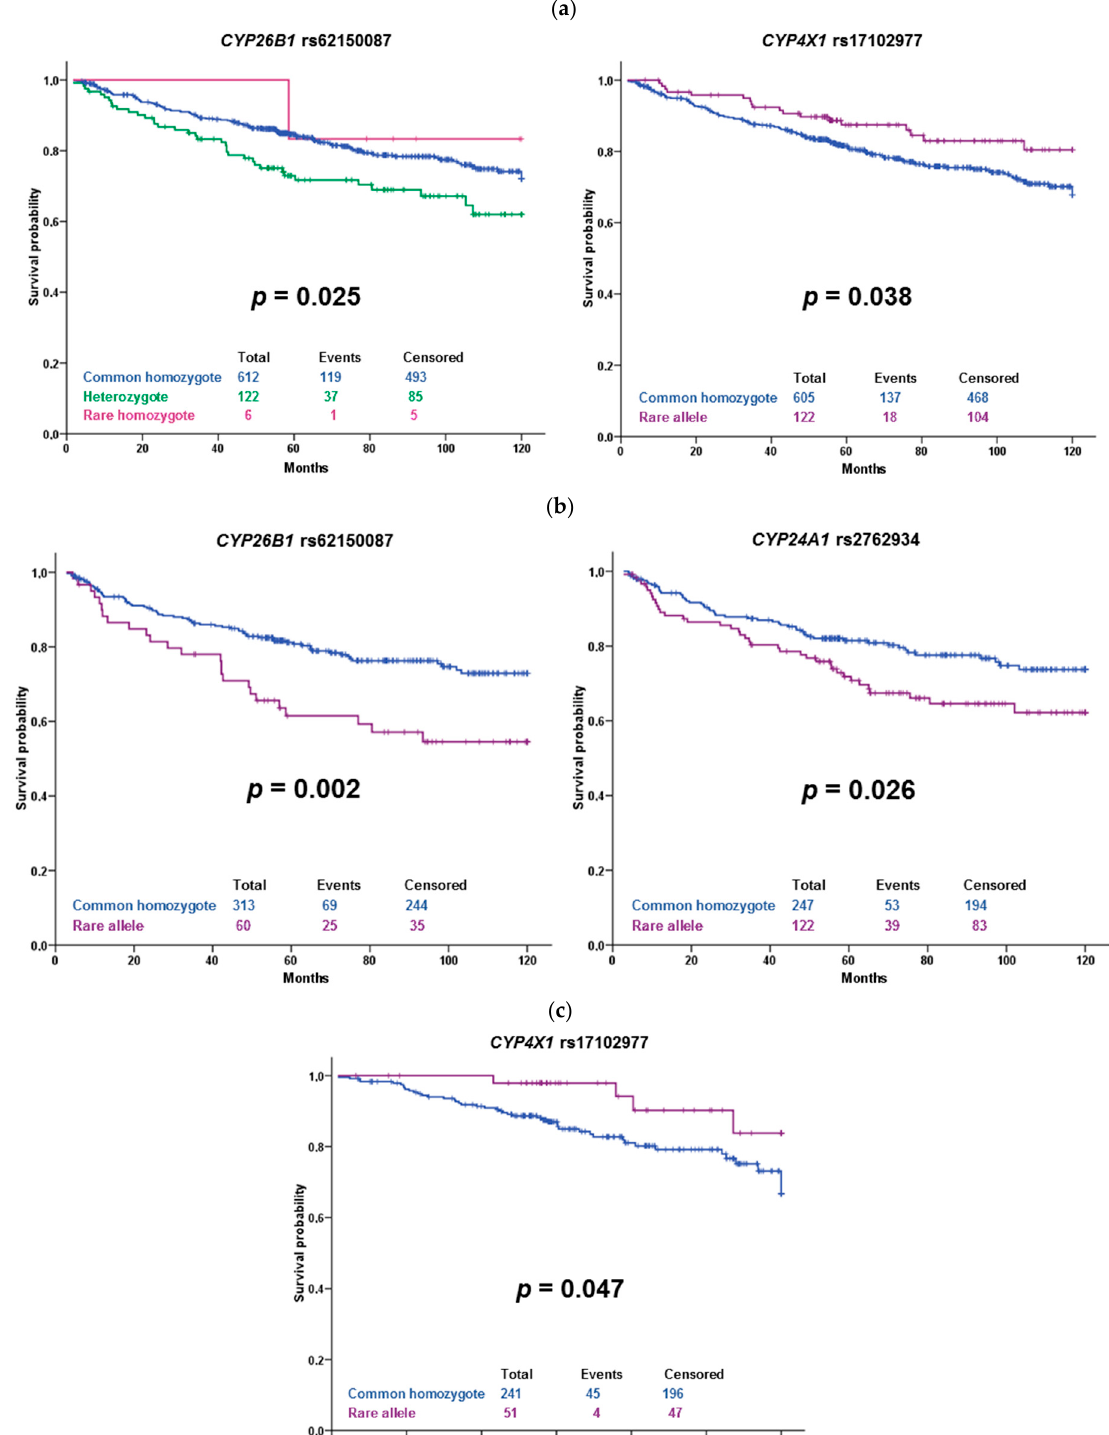
Figure 2. Common odds ratios of variants significantly associated with the response to neoadjuvant chemotherapy. OR = odds ratio.